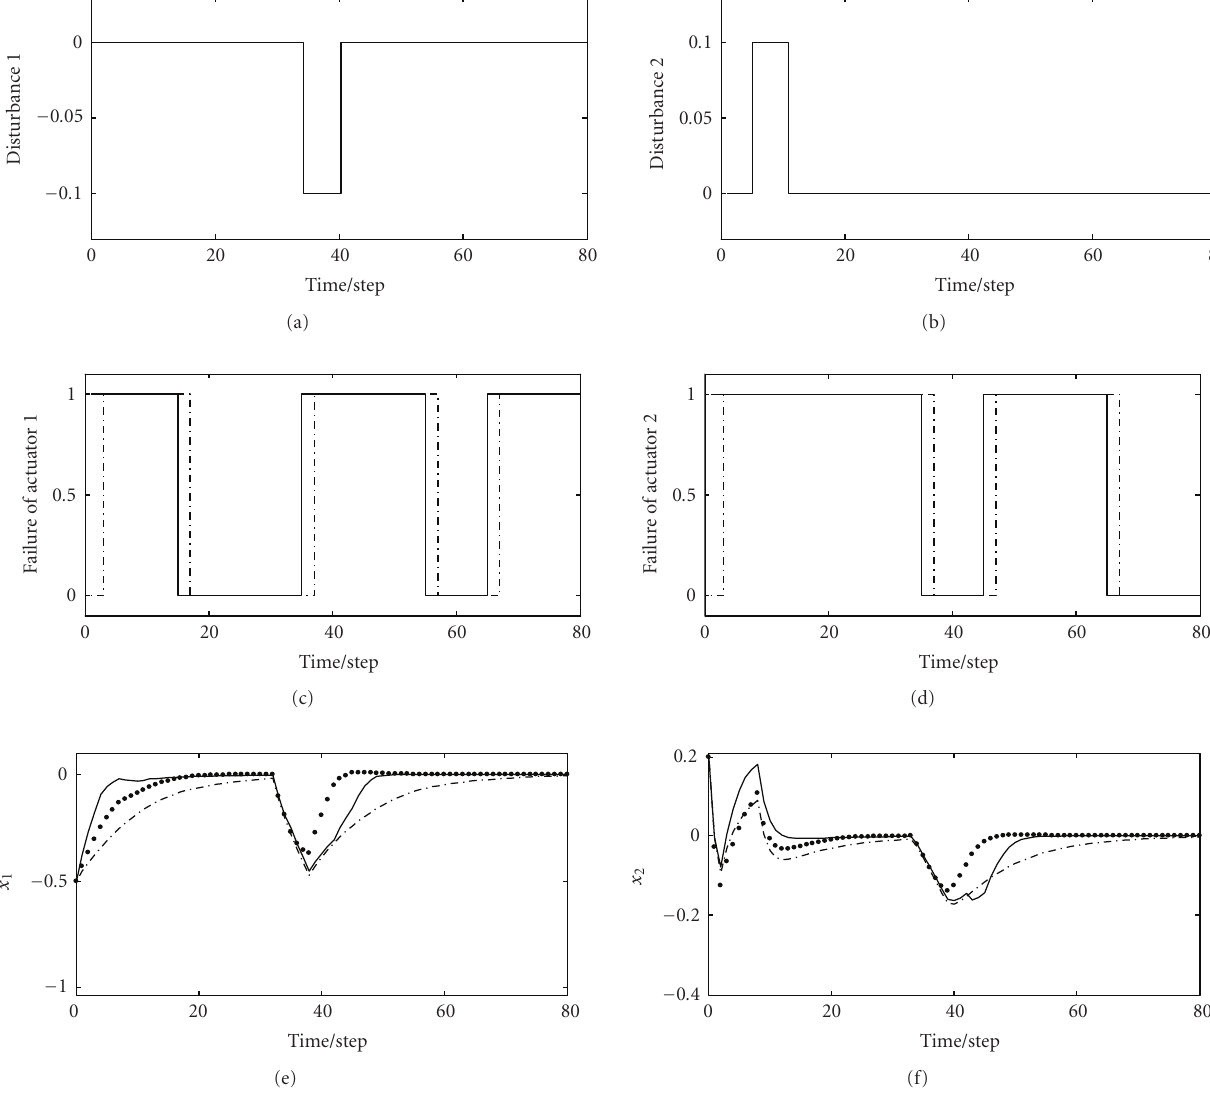
Figure 2: Disturbance, actuator failures, and state